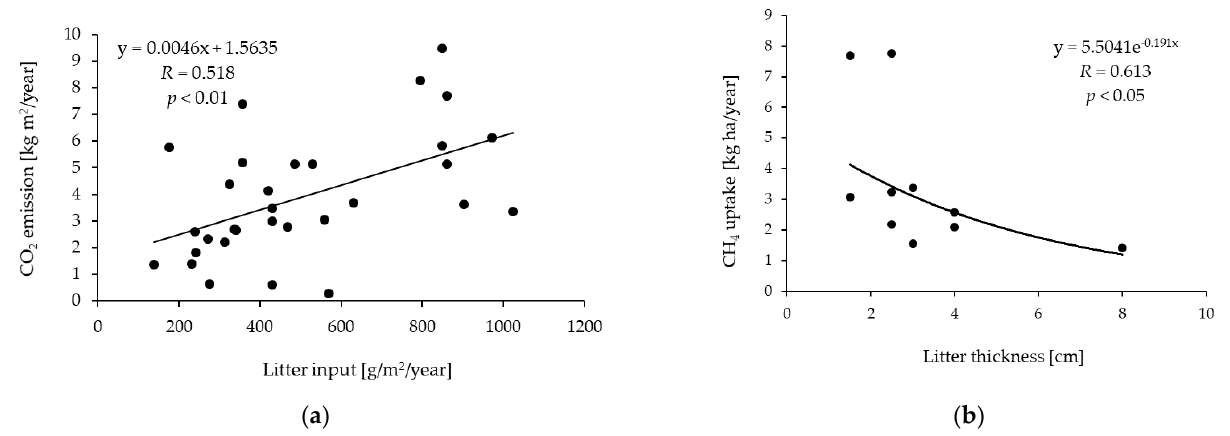
Figure A1. Relationship between ( a ) annual CO 2 emission and litter input (based on: [27,28,33,78,81,86,167,168]); ( b ) annual CH 4 uptake rates and thickness of litter layer (based on: [13,18,20,21,37,44,53,65,74,143,169–174]) from different forests.